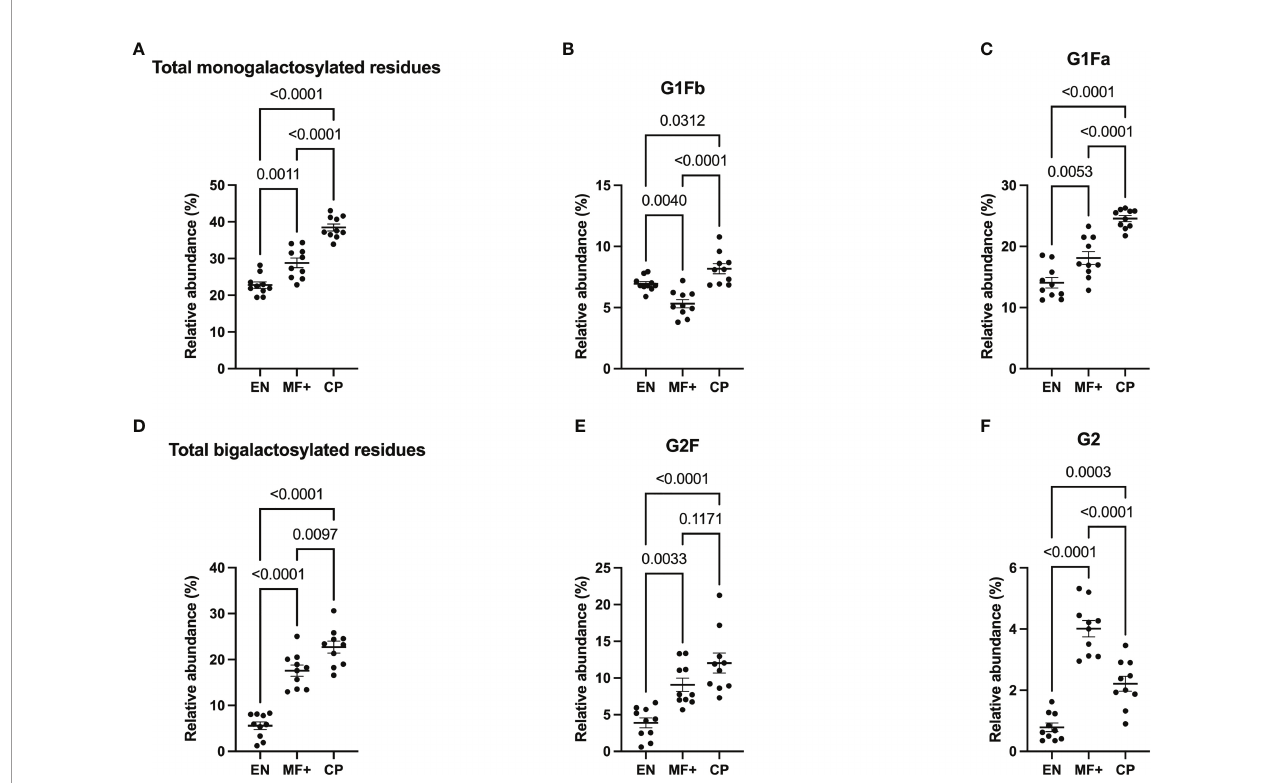
FIGURE 5 | Elevated IgG- galactosylation correlates with chronic pathology. Graphs represent the relative abundance of IgG-bound glycan structures with one (A – C) or two galactose molecules (D – F) in IgG puri fi ed from EN, MF+, and CP patients. Dots represent individual donors. Bars represent means ± SEM. Statistical analyses were performed using the Kruskal – Wallis nonparametric test with Dunn ’ s multiple comparison post-test. Signi fi cance is accepted when P <